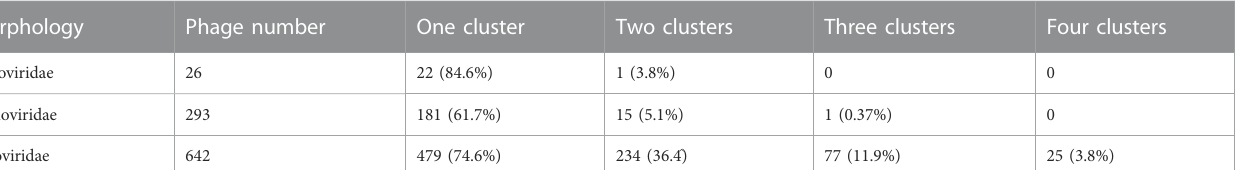
TABLE 2 Statistical results of cluster density analysis of 961